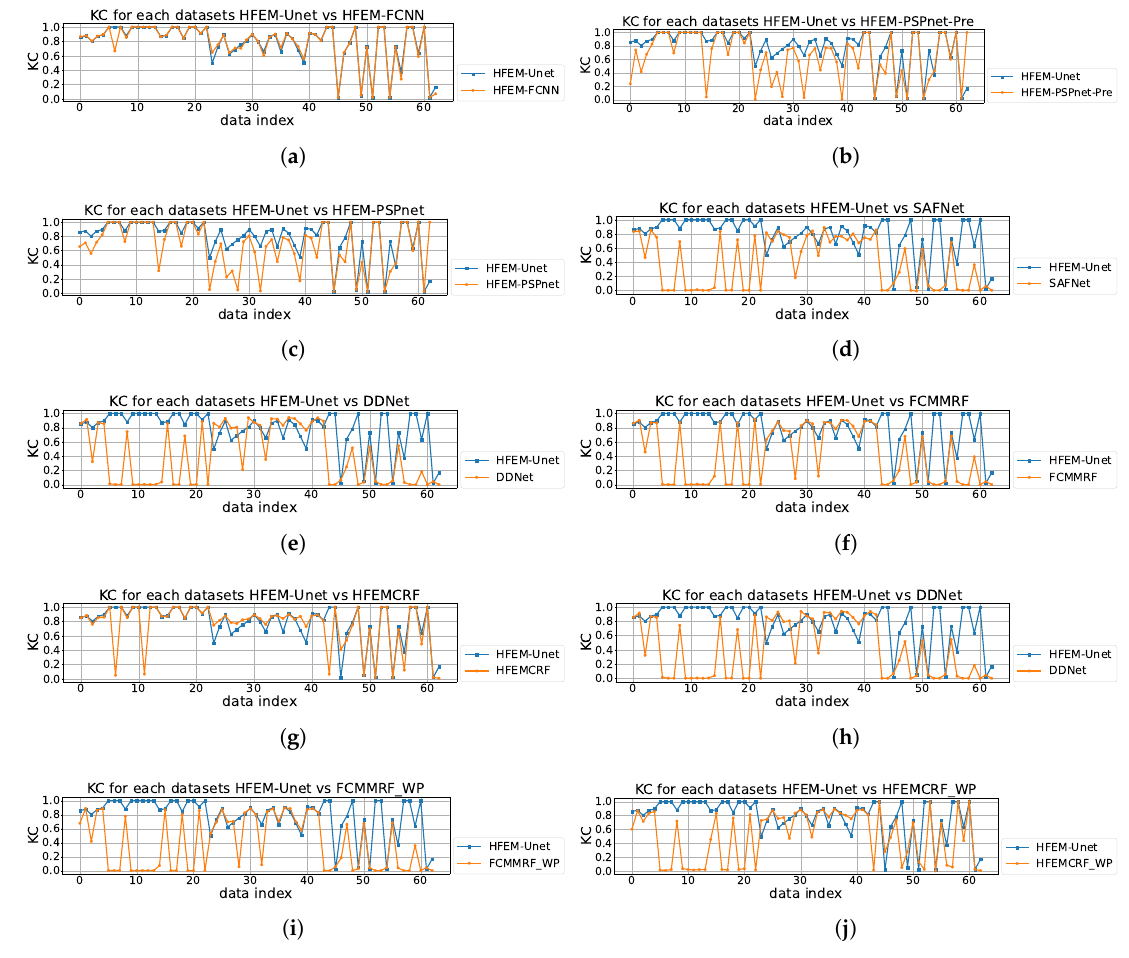
Figure 16. The kappa coefficient of different methods on all 63 datasets. ( a ) HFEM-Unet vs HFEM-FCNN. ( b ) HFEM-Unet vs. PSPNet-Pre. ( c ) HFEM-Unet vs. PSPNet. ( d ) HFEM-Unet vs. SAFNet. ( e ) HFEM-Unet vs. DDNet. ( f ) HFEM-Unet vs. FCMMRF. ( g ) HFEM-Unet vs. HFEMCRF. ( h ) HFEM-Unet vs. DDNet(WP). ( i ) HFEM-Unet vs. FCMMRF(WP). ( j ) HFEM-Unet vs. HFEM- CRF(WP).